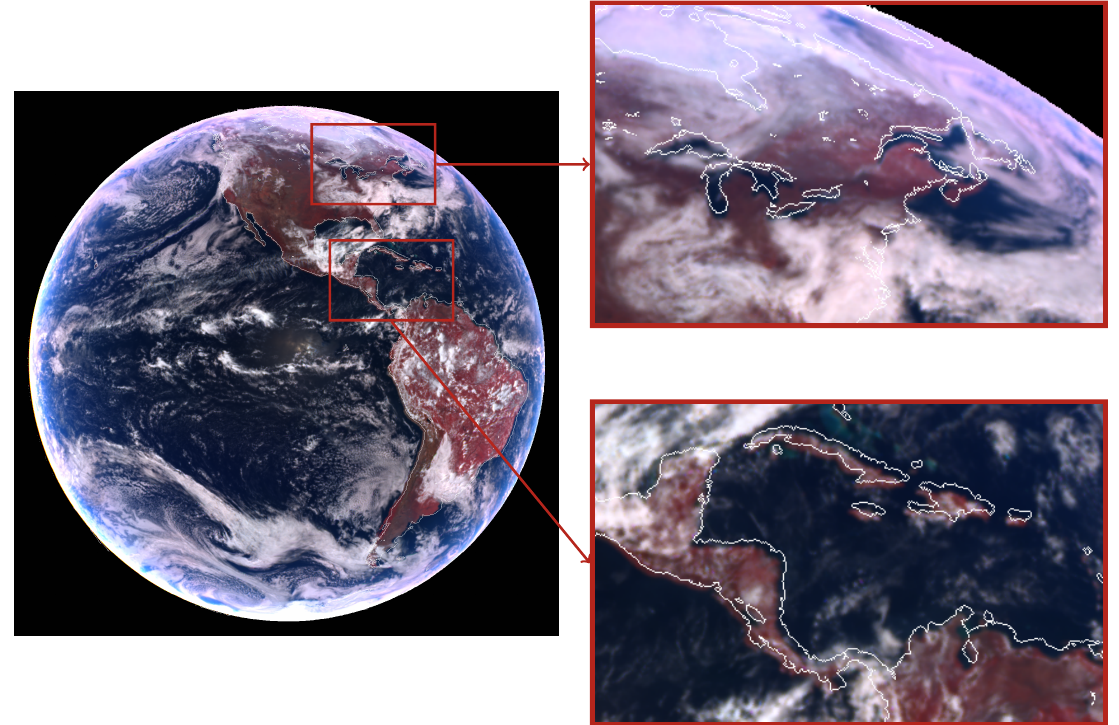
Figure 1. Example of reflectance image from EPIC L1B version 2 on 20 March 2016 at 18:36:56 UTC, with the coastline shape vector drawn in white line. On the left side, the full Earth’s disk is shown. On the right side, we zoom into two regions where the misregistration is